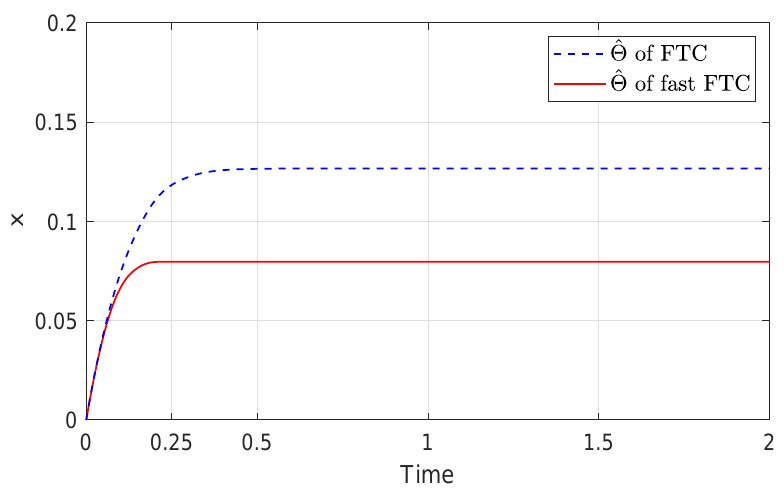
Figure 3. The trajectories of ˆ Θ ( t ) .